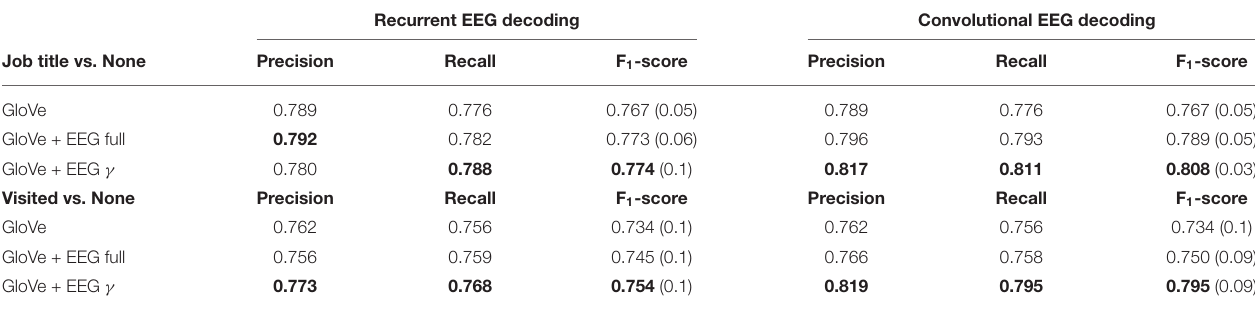
TABLE 10 | Binary relation detection results for both EEG decoding components for the relation types Job Title and Visited using GloVe embeddings. Recurrent EEG decoding Job title vs.